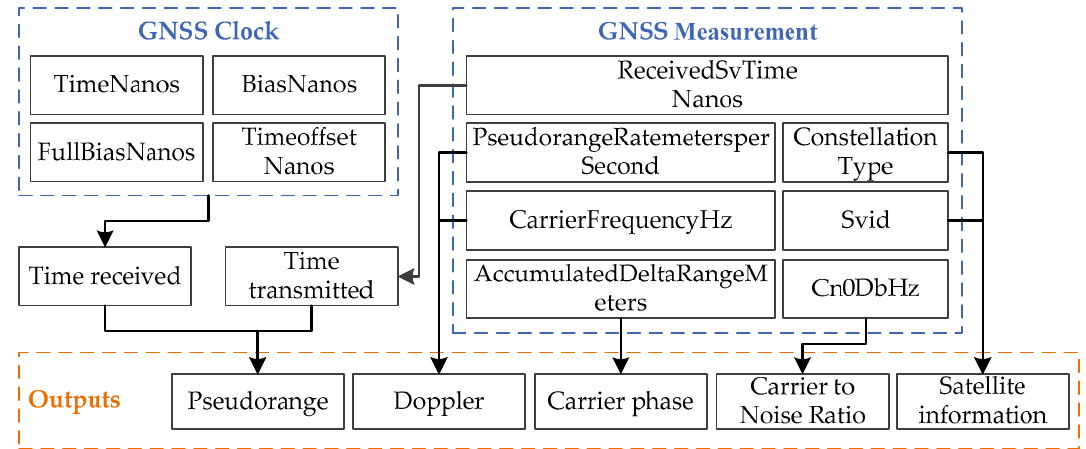
Figure 1. Generation principle of GNSS raw observations.